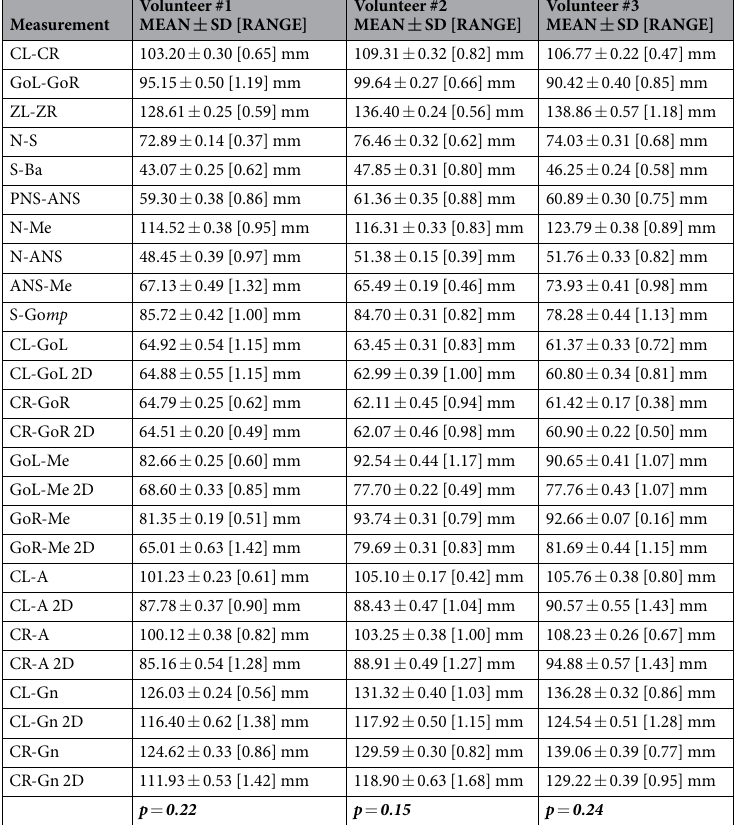
p = 0.15 p = 0.24 Table 4. Reproducibility of linear in vivo measurements. All distances were calculated from cephalometric landmarks determined on multiplanar reconstructions as shown in Fig. 3. 2D measurements were projected on the midsagittal plane (N_ANS_PNS). All mean, SD and range values refer to 5 MRI scans in different head positions for each study participant. All p-values were generated by repeated measures one-way analysis of variance. p-values > 0.05 indicate no significant differences between the 5 measurement rounds. Definitions of distances: CL-CR = Distance between points CL and CR (‘bicondylar width’); GoL-GoR = Distance between points GoL and GoR (‘bigonial width’); ZL-ZR = Distance between points ZL and ZR (‘bizygomatic width’); N-S = Distance between points N and S (‘anterior cranial base length’); S-Ba = Distance between points S and Ba (‘posterior cranial base length’); PNS-ANS = Distance between points PNS and ANS (‘palatal length’); N-Me = Distance between points N and Me (‘total anterior facial height’); N-ANS = Distance between points N and ANS (‘upper anterior facial height’); ANS-Me = Distance between points ANS and Me (‘lower anterior facial height’); S-Go mp = Distance from point S to midpoint of GoL and GoR (‘posterior facial height’); CL- GoL = Distance between points CL and GoL (‘left mandibular ramus height’); CR-GoR = Distance between points CR and GoR (‘right mandibular ramus height’); GoL-Me = Distance between points GoL and Me (‘left mandibular body length’); GoR-Me = Distance between points GoR and Me (‘right mandibular body length’); CL-A = Distance between points CL and A (‘left midfacial length’); CR-A = Distance between points CR and A (‘right midfacial length’); CL-Gn = Distance between points CL and Gn (‘left mandibular length’); CR-Gn = Distance between points CR and Gn (‘right mandibular length’). Abbreviations: Abbreviations/ definitions for cephalometric landmarks and planes are given in the legend of Fig. 4. 2D = two-dimensional; SD = standard